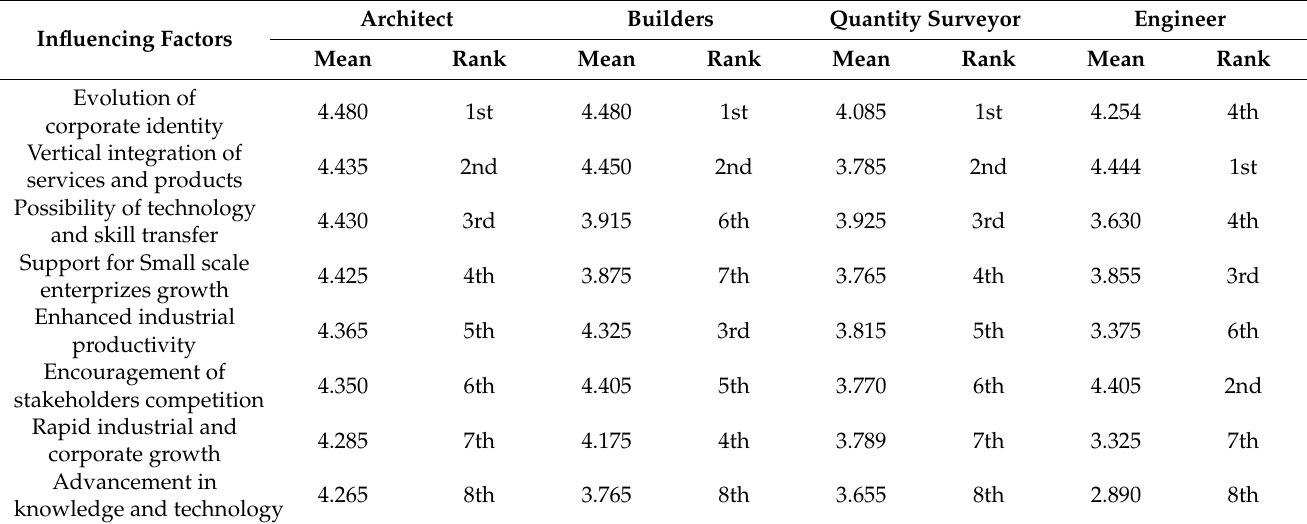
Table 13. Factors Influencing Effective Practical Adaptation of Construction 4.0 in Industrial Development. Influencing Factors